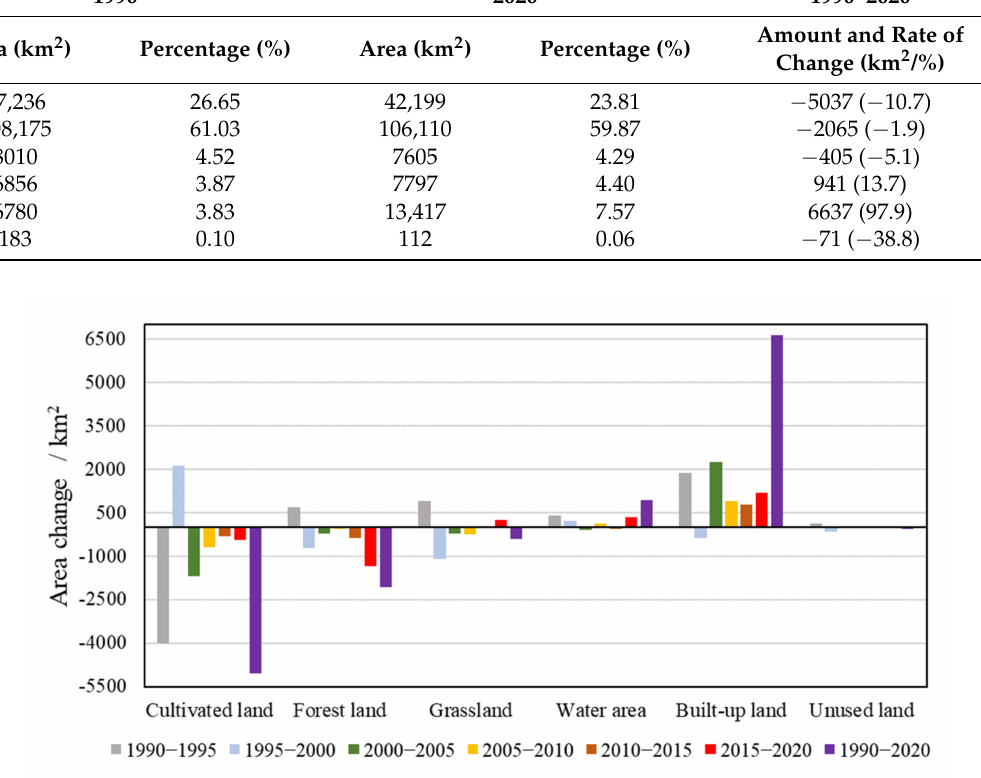
Figure 3. Area changes of each land use type in Guangdong, 1990–2020.